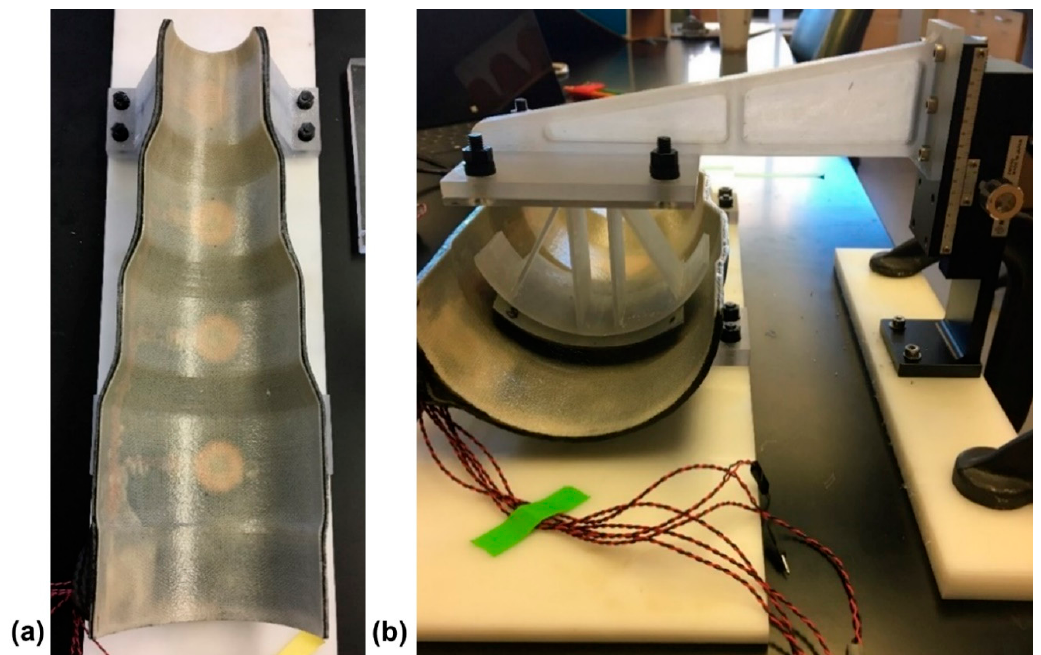
Figure A2. Benchtop setup to evaluate effects of curvature on sensor output: ( a ) composite with embedded sensors; ( b ) 3D printed mounding pieces, probe arm, and z-axis stage used to hold the target in a defined curvature at specified distances from the base.